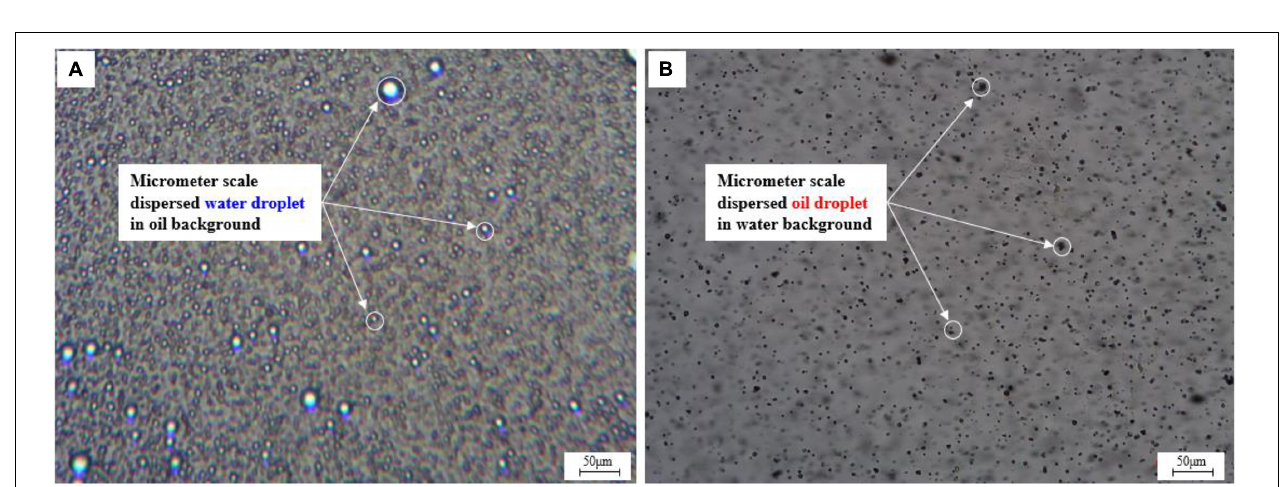
FIGURE 12 | Emulsion (upper or lower emulsion) type of effluent from sandpack. (A) Effluent collected after 0.35 PV of 0.02 mol/L NaOH flooding at 70 ◦ C. (B) Effluent collected after 0.35 PV of 0.02 mol/L NaOH flooding at 20 ◦ C. (C) Effluent collected after 0.35 PV of 0.005 mol/L Na 2 CO 3 flooding at 70 ◦ C. (D) Effluent collected after 0.35 PV of 0.05 mol/L Na 2 CO 3 flooding at 20 ◦ C.